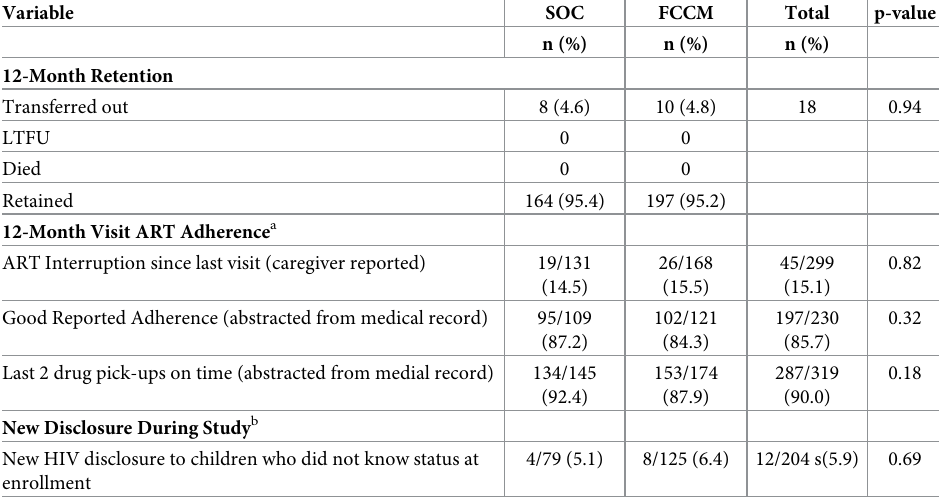
Table 5. Retention, adherence, and disclosure HIV-positive children during the